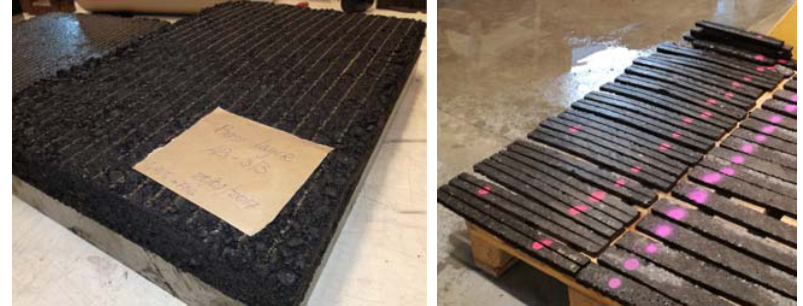
Figure 4. Prefabricated asphalt (AC-14) specimens with grooves for preparation of FBG embedment.